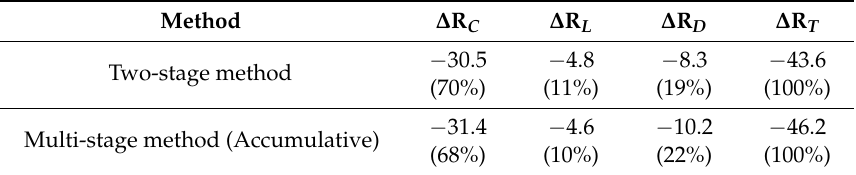
Table 7. Summary for results of two-stage method and multi-stage method (unit: km 3